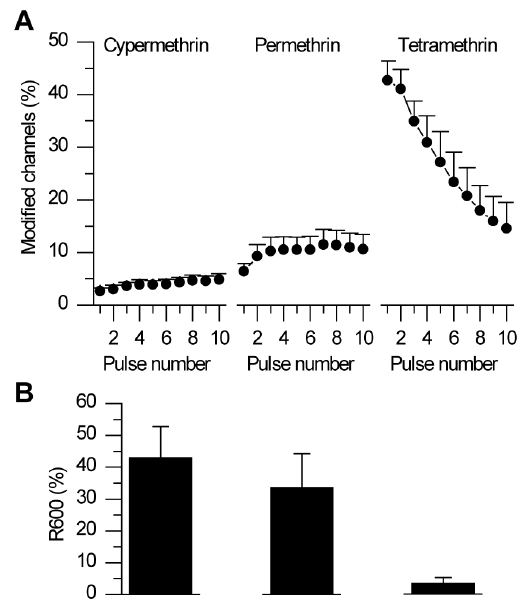
Figure 3. Use-dependent sommation of modified channels and tail current inactivation kinetics in ALNs. Mean time course of pyrethroid-modified channels along with protocol shown in Figure 2 (n=7, 10 and 10 ALNs for cypermethrin, permethrin and tetramethrin, respectively). The percentage of modified channels is calculated from tail currents amplitude according to Eqn 3. Whereas cypermethrin and permethrin induce an increase in % of modified channels, tetramethrin shows the opposite effect. B2. Kinectics of tail currents estimated by the R600 value, i.e. the percentage of residual tail current 600 ms after the end of the tenth pulse of the 10-pulse protocol. Tetramethrin induces faster decaying tail currents than cypermethrin or permethrin.